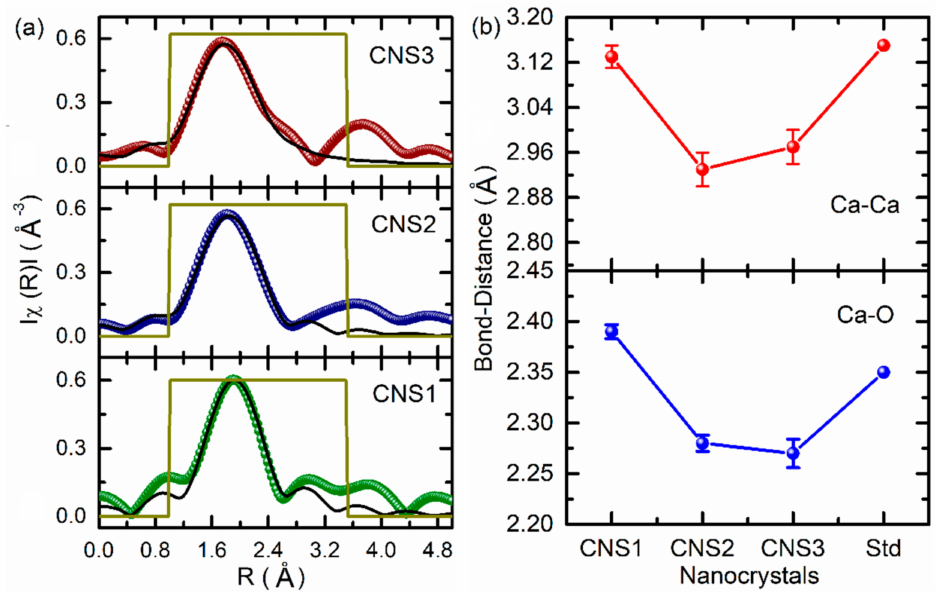
Figure 7. ( a ) Non-phase corrected simulated Fourier transform of EXAFS spectra; ( b ) Ca-O and Ca-Ca bond lengths of CNS1, CNS2 and CNS3 nanocrystals.